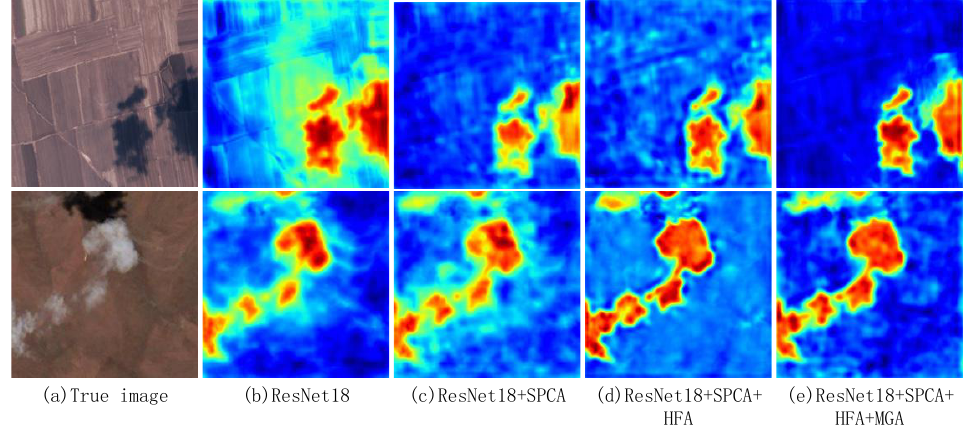
Figure 8. Heatmap in the ablation experiment. Red indicates that the classification weight of the target category is high, and blue is the opposite.